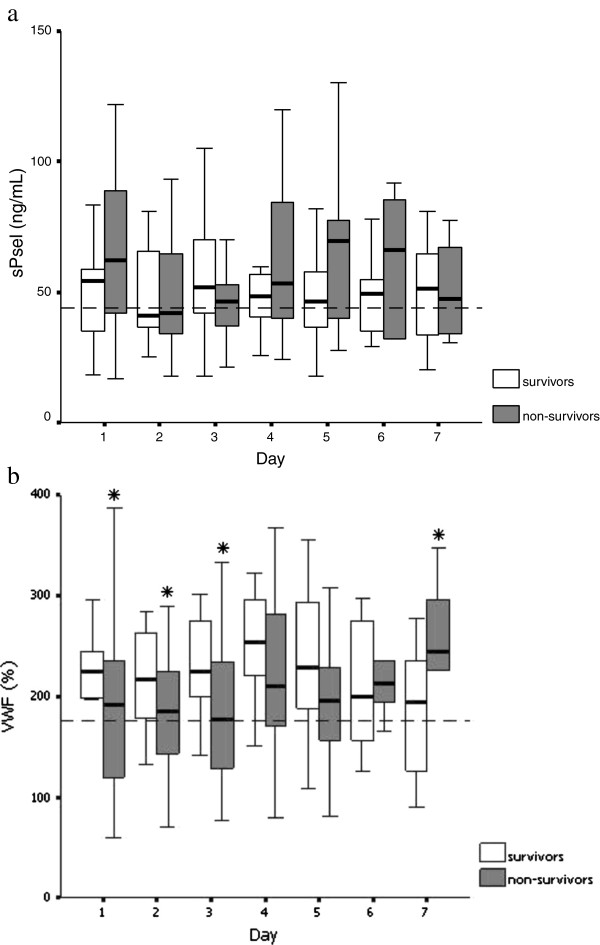
Evolution of sPsel and VWF levels during the first week after admission according to outcome. (a) Evolution of sPsel levels (ng/ml) during the first week after admission according to outcome. The dashed line represents the upper limit of normal for sPsel levels (44 ng/ml). No significant differences were found in sPsel levels on each day between survivors and nonsurvivors (by Student’s t test or the Mann–Whitney U test). (b) Evolution of VWF levels (%) during the first week after admission according to outcome. The dashed line represents the upper limit of normal for VWF levels (176.0%). *p < 0.05 compared with survivors (Mann–Whitney U test).